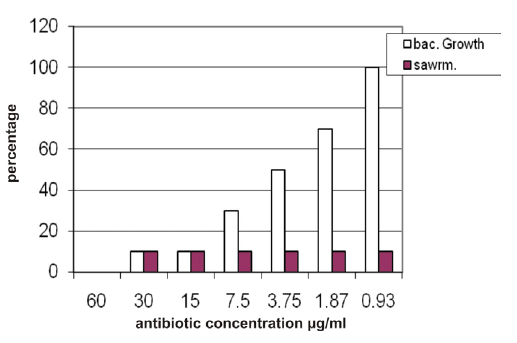
Fig. 2. Effect of sefixime on growth and swarming of Proteus mirabilis